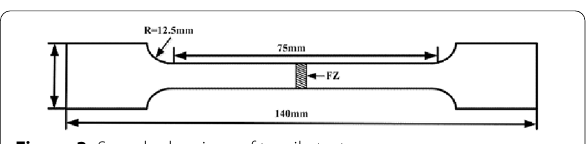
Figure 3 Sample drawings of tensile test